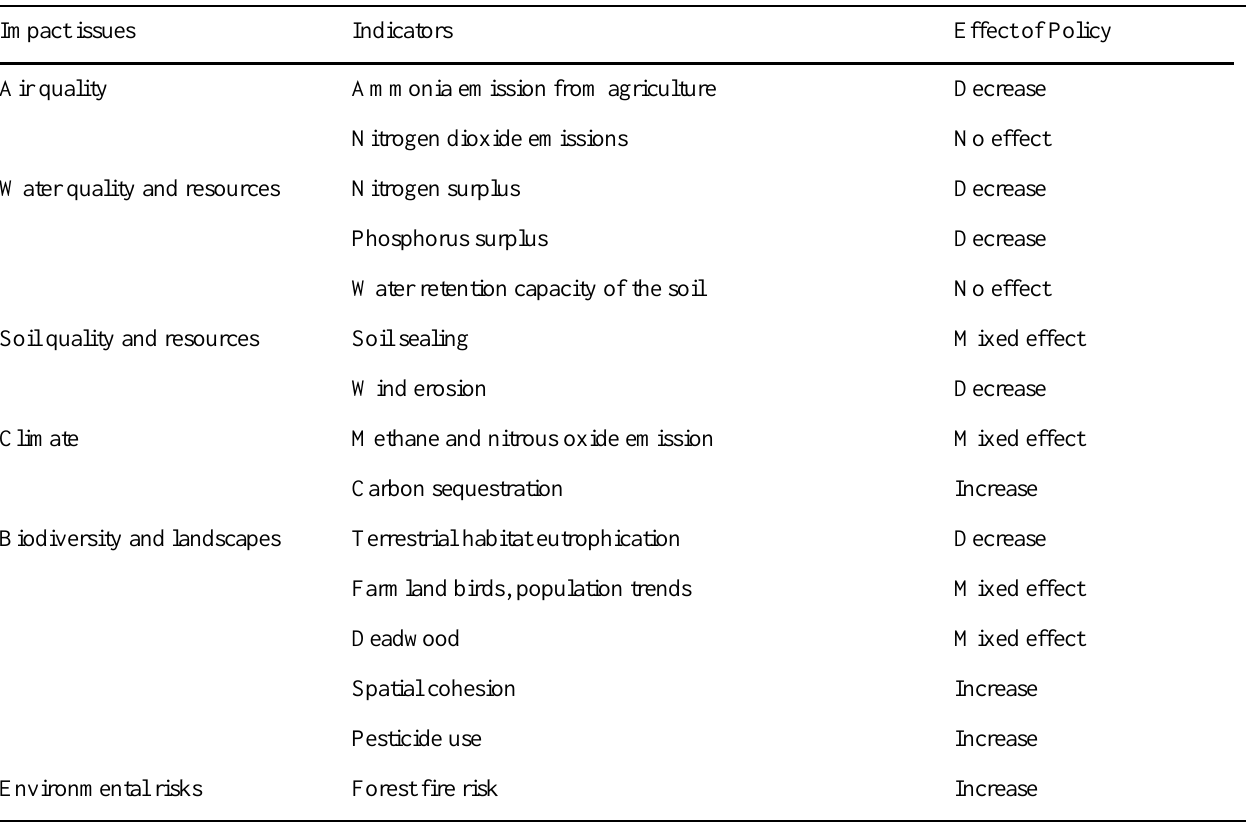
Table 1 . Common Agricultural Policy financial reform scenario: 100% cut of Common Agricultural Policy first pillar measures (market support and direct income support); and re-investment of savings in research and development. Summary of the impacts for environmental indicators in